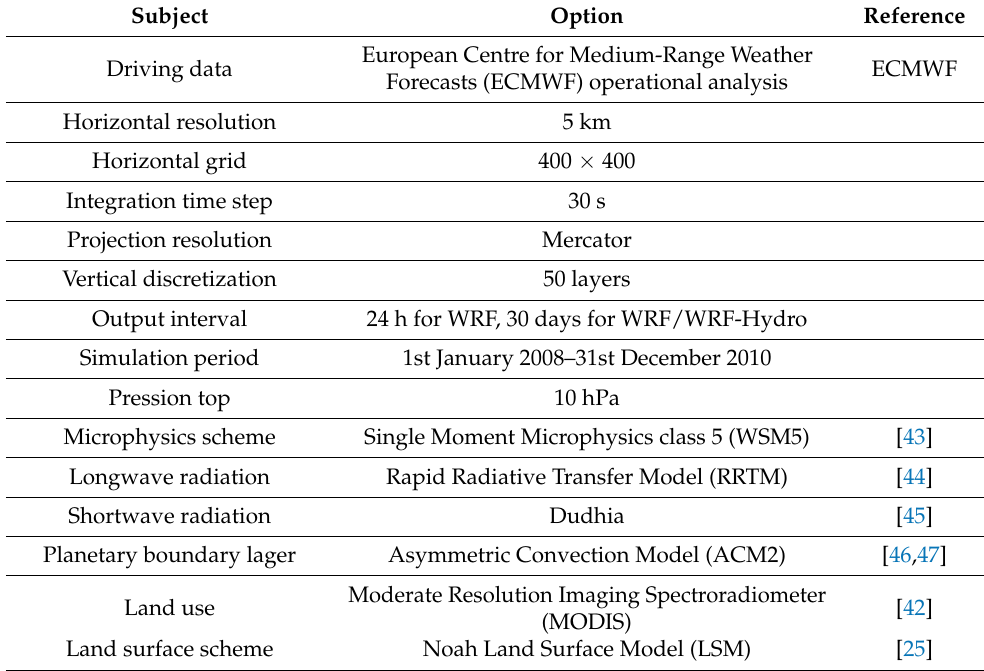
Table 1. Experimental details of the atmosphere model, WRF-only and